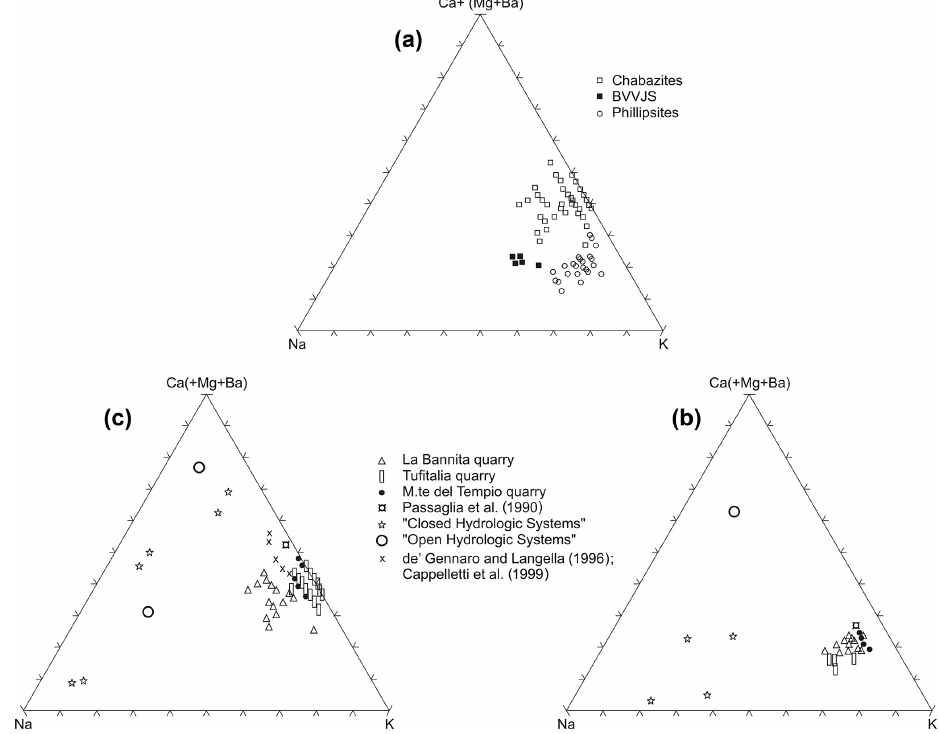
Figure 7. (a) Molar exchangeable cation content for TRS chabazites (empty square), TRS phillipsites (empty circles), and TRS fresh glasses (full squares). Values were calculated on the base of half of Barth’s anhydrous standard cell content (Barth, 1952) for both zeolites and glasses. Mole plot of exchangeable cation content in TRS phillipsites (b) and chabazites (c) . Zeolites from open and closed hydrologic systems are from Sheppard and Gude (1970, 1973), Hay (1964), and Iijima and Harada (1969).